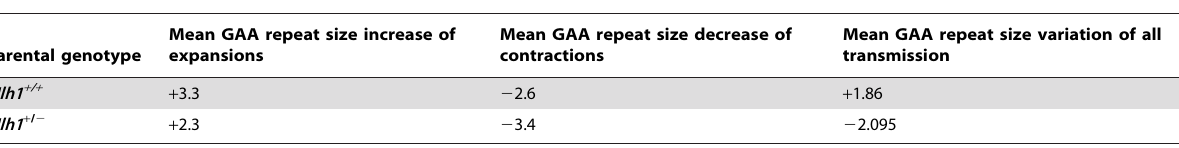
Table 2. Mean intergenerational GAA repeat size variations.